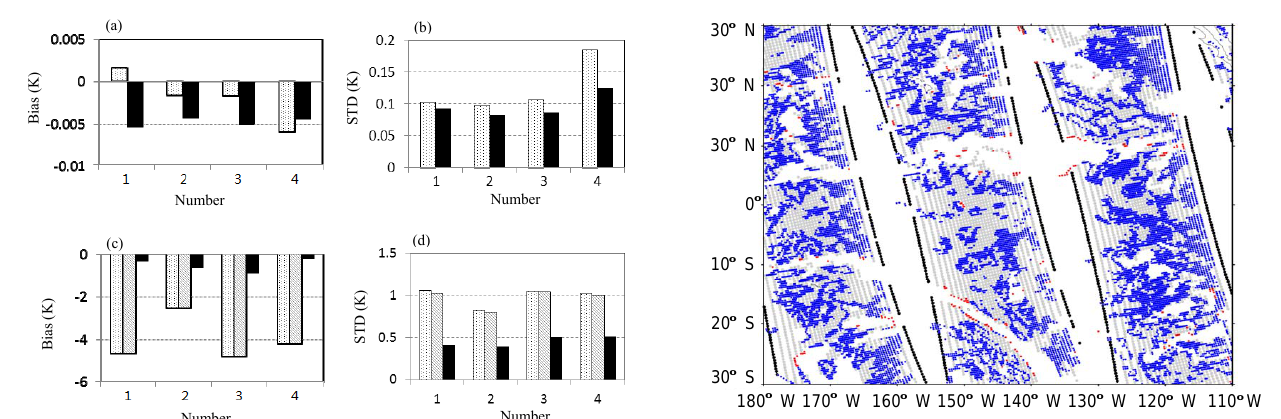
Figure 5. (a) Bias and (b) standard deviation of the striping noise from MWTS-2 channels (dotted bars) and ATMS channels (solid bars) during 1–27 July 2014. The numbers from 1–4 indicate chan- nels 5–8 for MWTS-2 and channels 7–10 for ATMS. (c) Bias and (d) standard deviation of brightness temperature differences be- tween observations and model simulations from MWTS-2 chan- nels before (dotted bars), after (dashed bars) removing the striping noise and ATMS channels (solid bars) after removing striping noise during 1–27 July 2014.